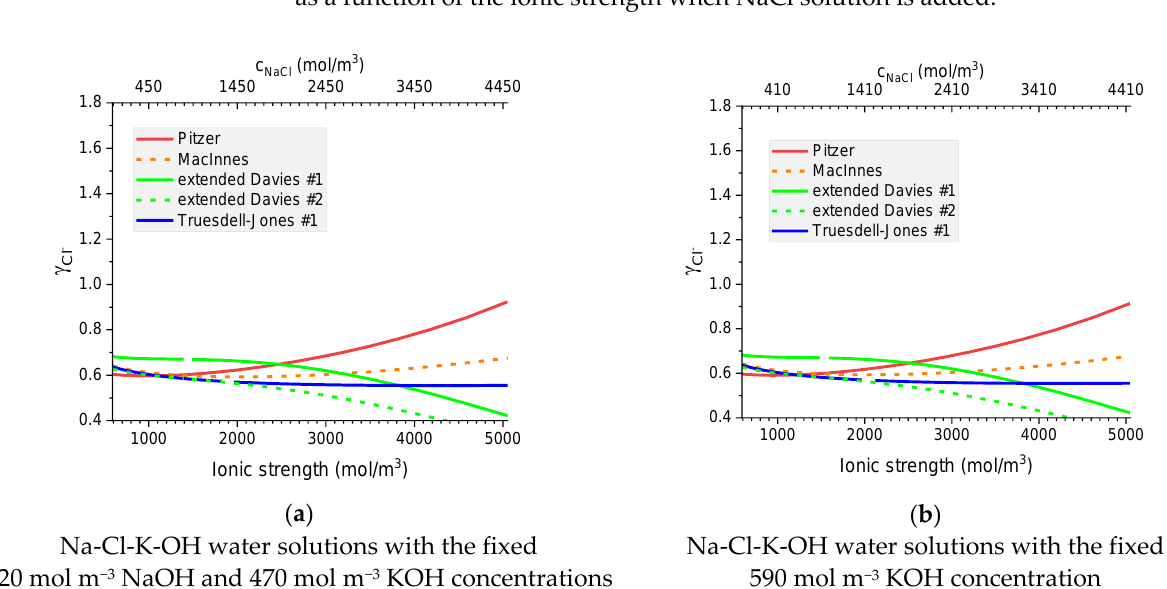
Figure 11. Molar individual activity coefficient of Cl − in Na-Cl-K-OH water solutions as a function of ionic strength for the fixed: ( a ) KOH concentration 470 mol m − 3 ; and NaOH concentration 120 mol/m 3 and ( b ) KOH concentration 590 mol m − 3 . Notations #1 and #2 correspond to different ionic radii — see Tables 4 and 5.